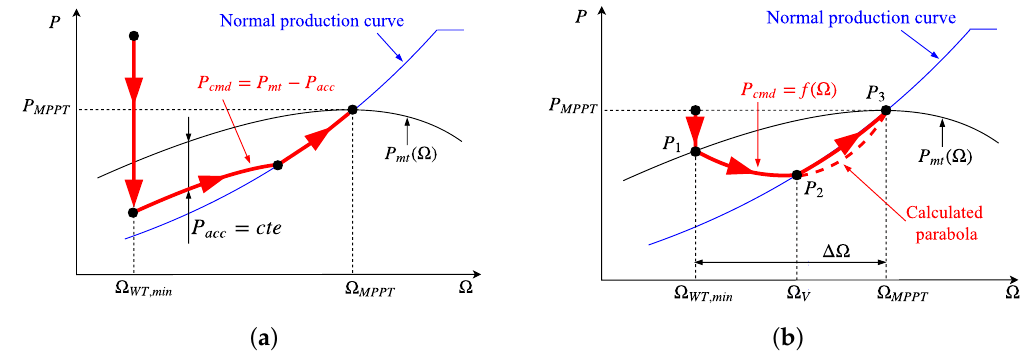
Figure 6. Comparison between recovery operation modes. ( a ) Recovery operation mode in [23];